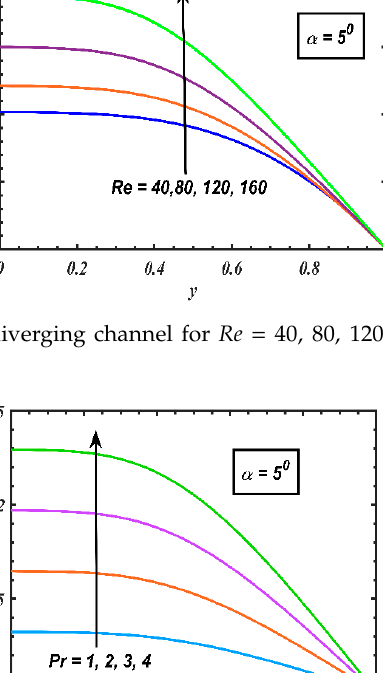
Figure 1. Jeffery-Hamel flow in a converging/diverging channel with angle 2 et al. [12]).